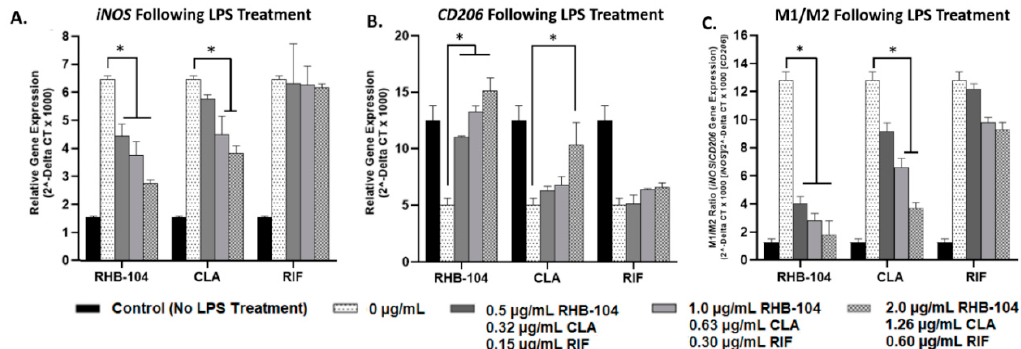
Figure 3. E ff ect of RHB-104 and its major components on M1 / M2 Macrophage Polarization in lipopolysaccharide (LPS)-treated macrophages. RT-PCR was used to measure expression of ( A ) iNOS (M1), and ( B ) CD206 (M2) in LPS-treated macrophages (24 h) following dose-dependent treatment with RHB-104 (0, 0.5, 1.0, 2.0 µ g / mL), CLA (0, 0.32, 0.63, and 1.26 µ g / mL), and RIF (0, 0.15, 0.30, 0.60 µ g / mL) for 24 h. ( C ) illustrates the calculated iNOS / CD206 (M1 / M2) ratio for all treatments. * p < 0.05. Table 2. NF- κ B p65 activation scores in macrophages infected with MAP or treated with LPS following treatment with RHB-104 and its major